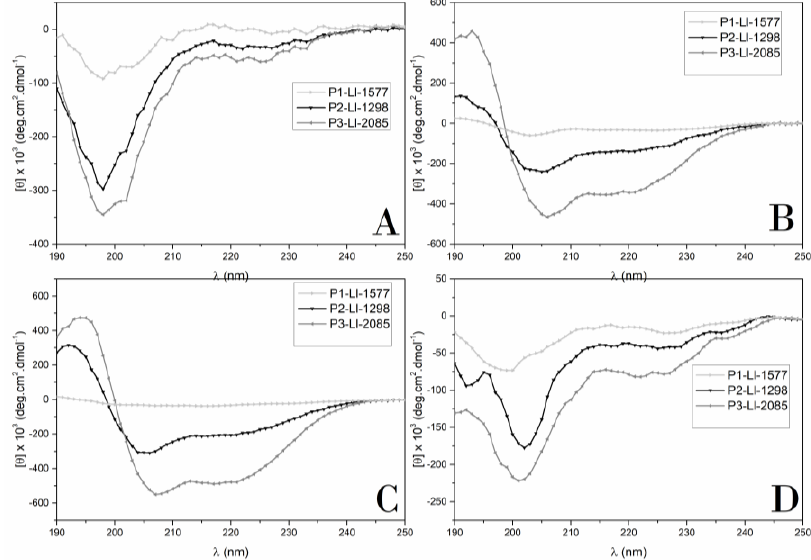
Figure 4. Circular dichroism spectra of synthetic analogs. ( A ) water, ( B ) TFE/ H2O (50%, v / v ) ( C ) DPPG, ( D ) DPPC. Peptide concentration: 0.2 mg/mL.